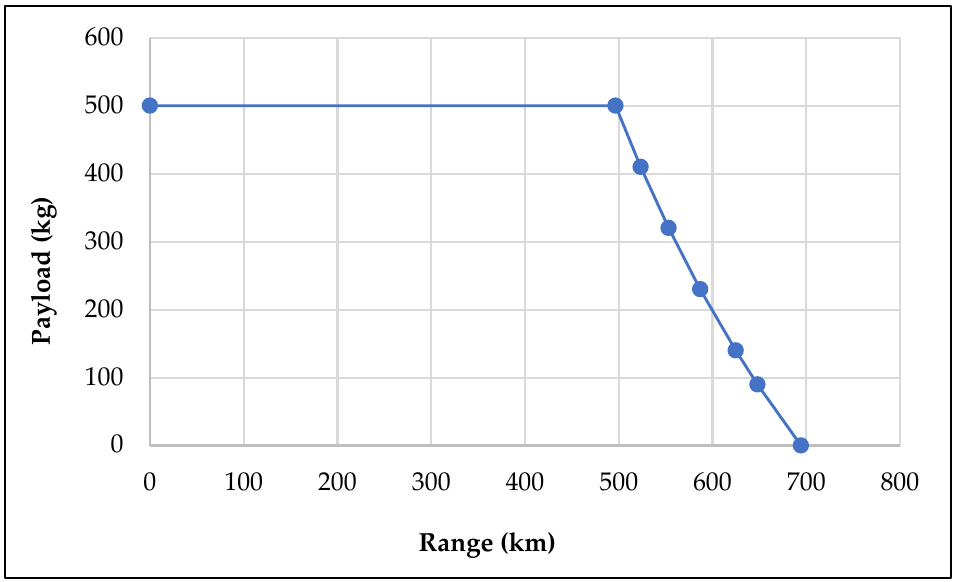
Figure 6. Payload versus range diagram.